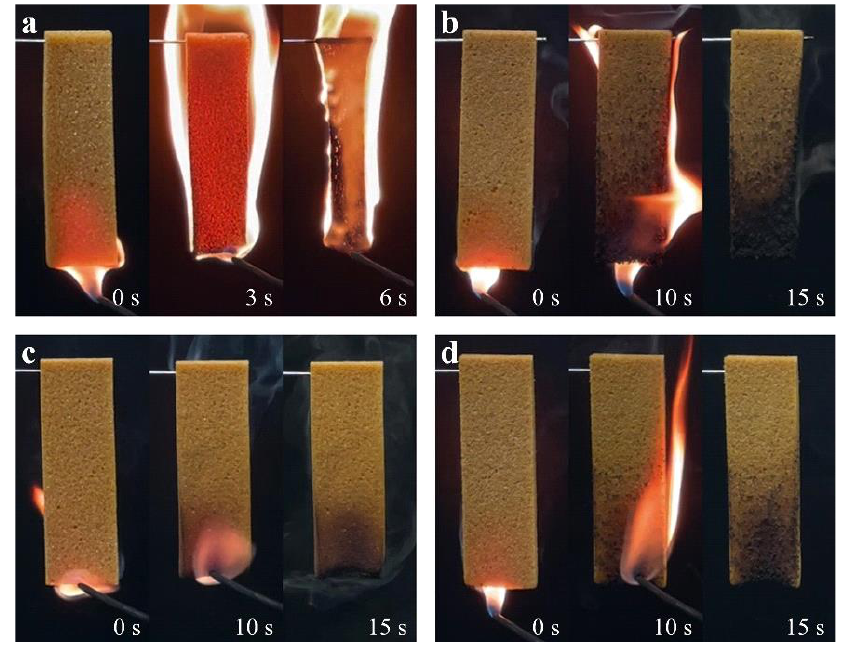
Figure 7. Digital photos of partial RPIF ignited at different times, ( a ) RPIF-0-0, ( b ) RPIF-5-0, ( c ) RPIF-0-5, and ( d ) RPIF-5-5. 0-5, and ( d )